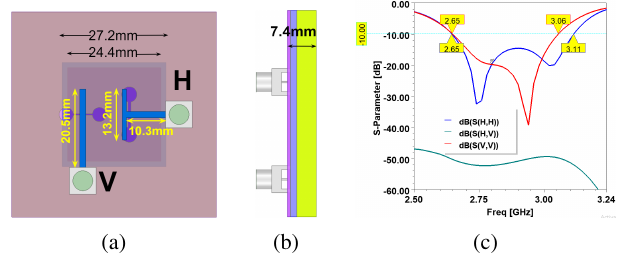
FIGURE 2: (a) Bottom view of the antenna element (b) Side view of antenna element (c) S-parameter plot High-Frequency Structure Simulator (HFSS) is used for the simulation. The simulated return loss is less than -15 dB for both H and V ports while the isolation between the ports is more than 50 dB for the frequency range of 2.65 to 3.0 GHz as shown in Figure